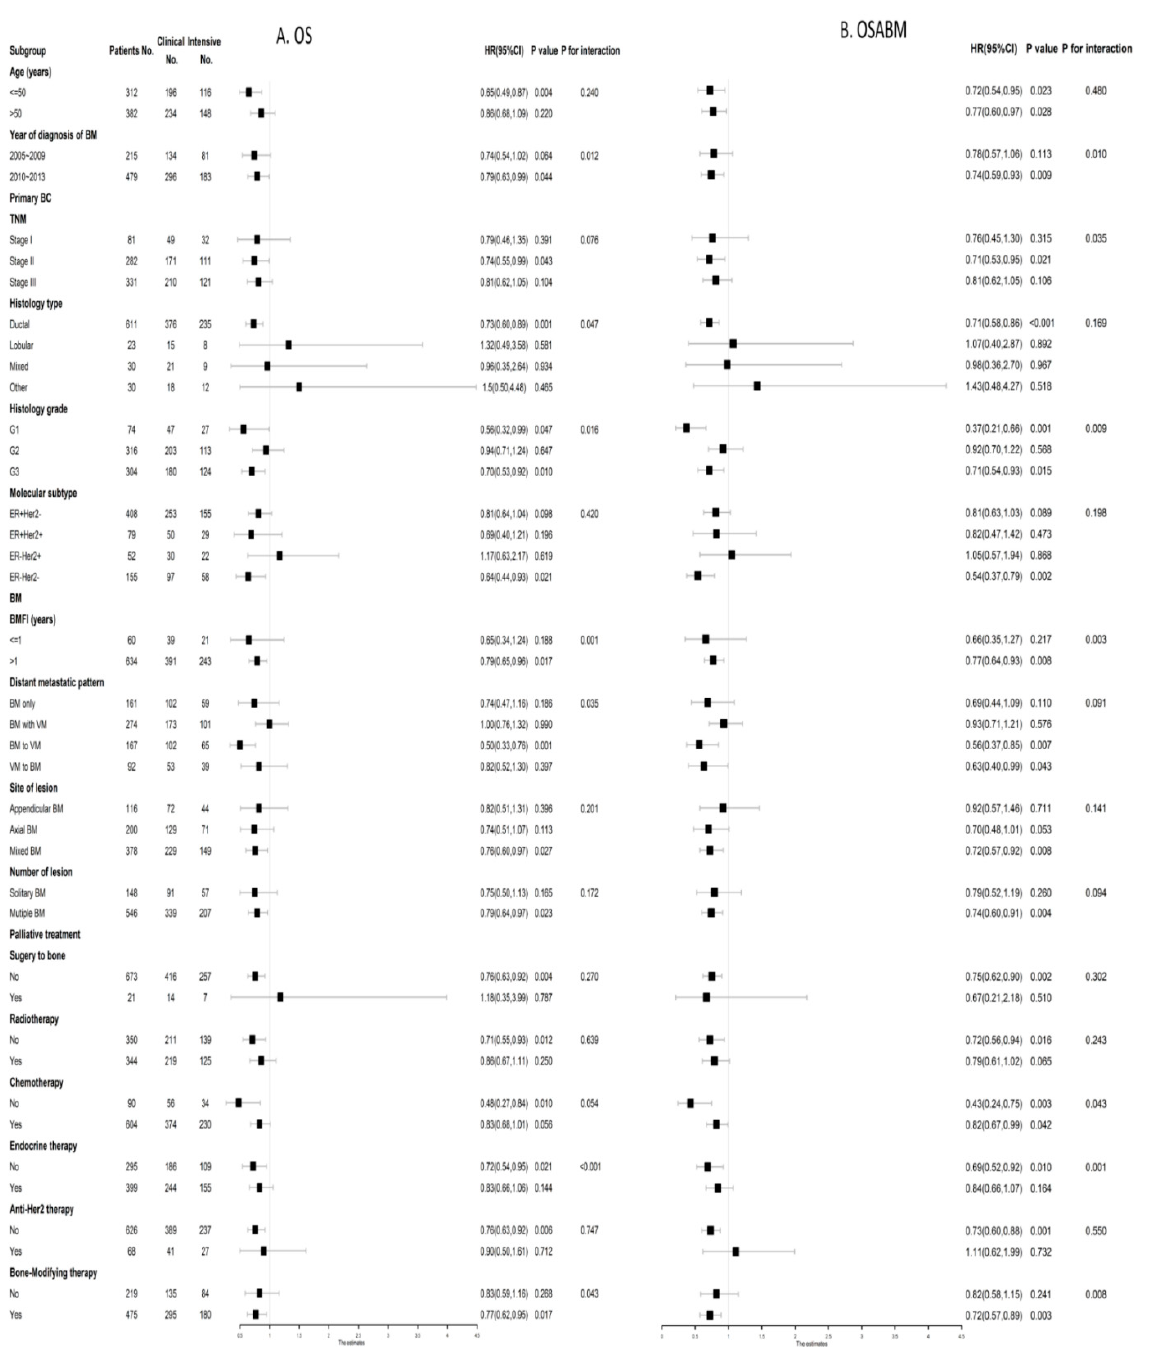
Figure 3. Forest plots of interaction and univariate subgroup analyses on the association between postoperative follow-up strategies (Intensive postoperative BS vs. Clinical postoperative BS) and ( A ) OS and ( B ) OSABM of patients with breast cancer with BM after PSM. Abbreviations: BS = bone scan; BM = bone metastasis; BMFI = bone metastasis-free interval; 95%CI = 95% confidence interval; ER = estrogen receptor; Her2 = Human epidermal growth factor receptor 2; HR = hazard risk; No. = Numbers of patients; OS = overall survival; OSABM = overall survival after bone metastasis; PSM = propensity scores